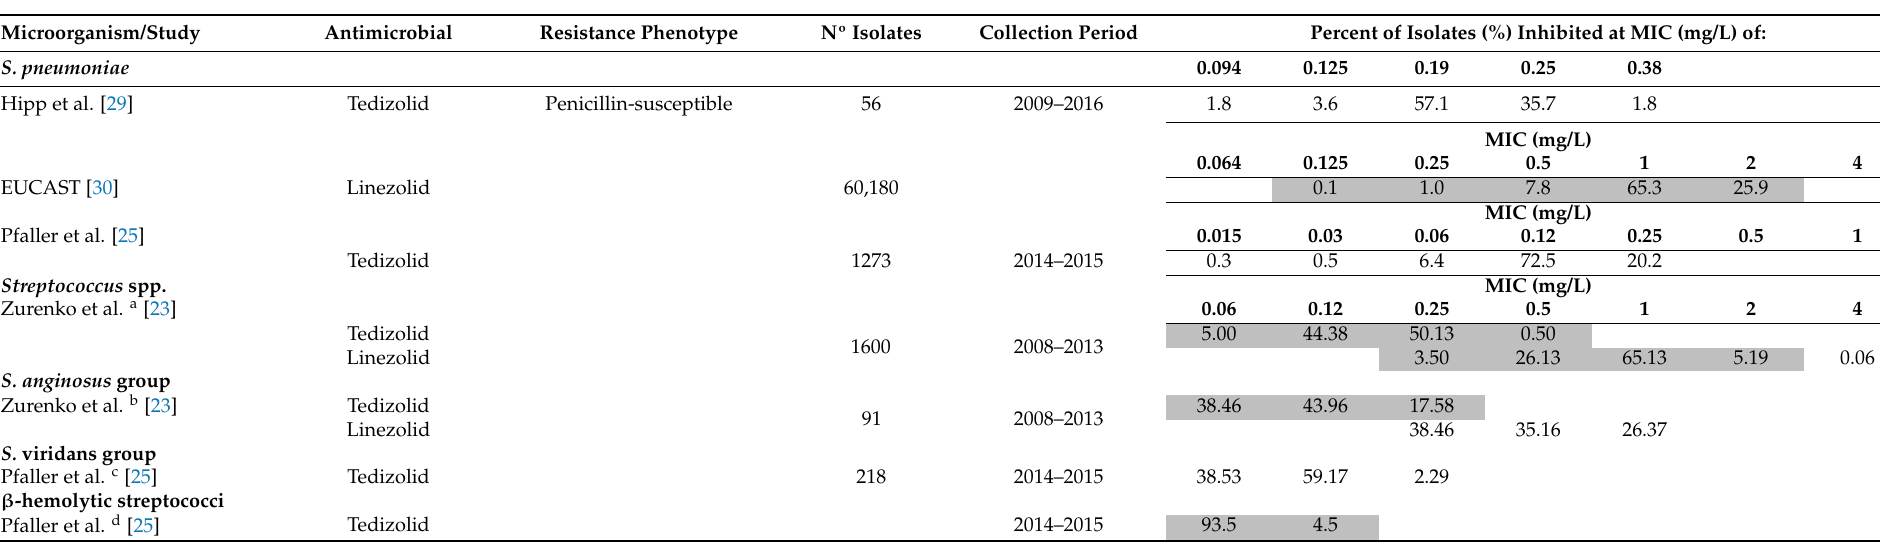
Table 4. Resistance phenotype, number of isolates, collection period, and antimicrobial activity of streptococci for tedizolid and linezolid.